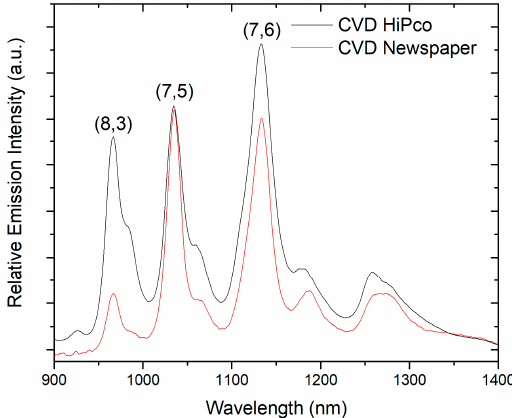
Figure 2. A comparison of the 660 nm excited fluorescence spectra from chemical vapor disposition (CVD) HiPco SWCNTs (black line) and CVD grown soot on “Voice of Asia” newsprint substrate (red line), depicting specific chiralities of semi-conducting SWCNTs present in both samples.